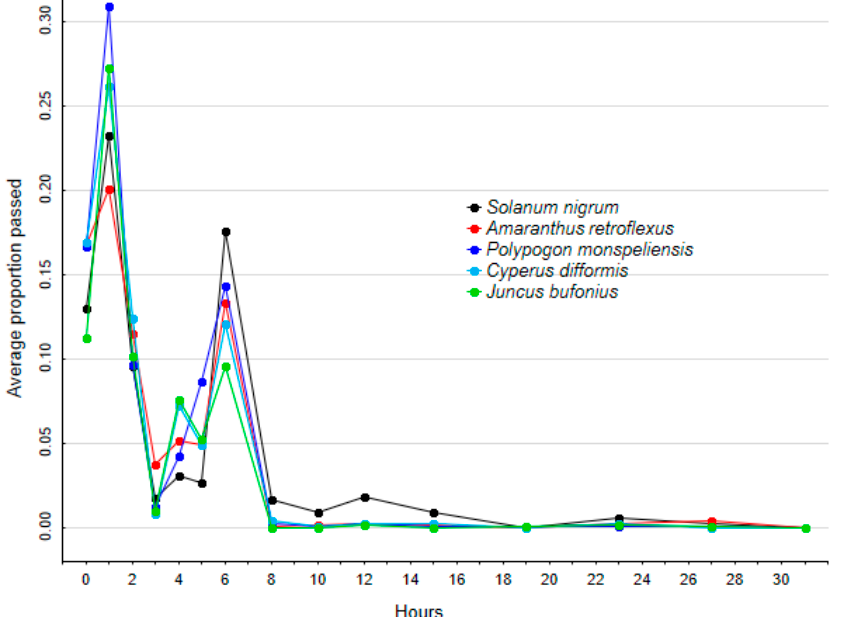
Figure 1. Average proportions of intact seeds recovered from gull faeces, at each sampling time for each plant species. Table 1. (a) Percentage of seeds of each plant species that survived gut passage through seven lesser black-backed gulls. (b) Average retention time (in hours) for seven gulls. S.D.: Standard deviation, Min: minimum, Max: maximum.